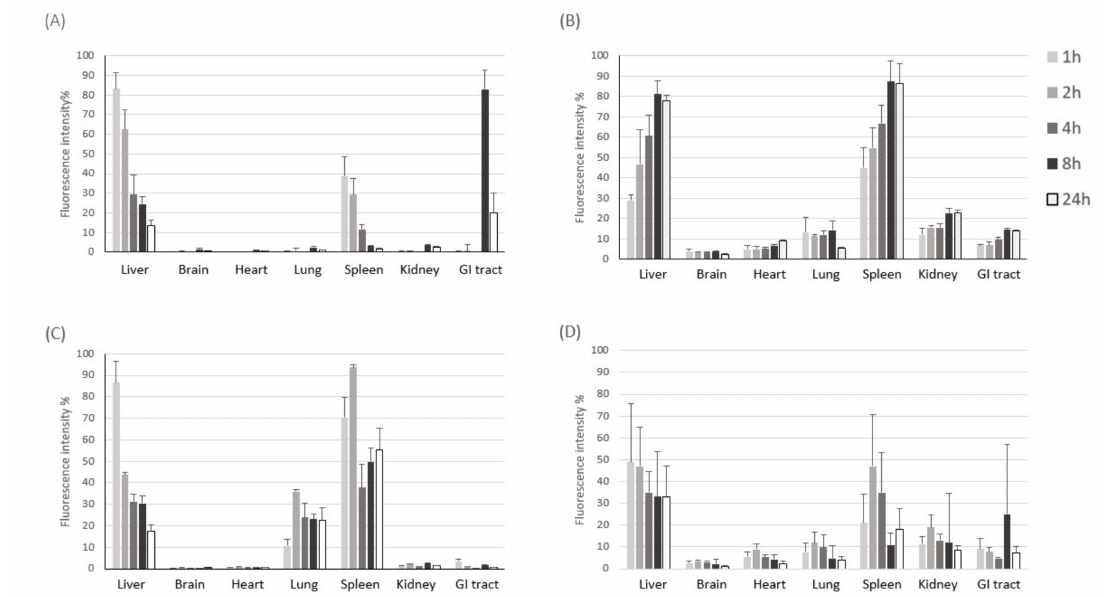
Figure 3. NIR fluorescence imaging of ex vivo organs after intravenous injection of HEK293T cell-derived exosomes and PEGylated liposomes. ( A , B ) Fluorescent signal intensity in each organ harvested at different time points after intravenous injection of DiR-labeled exosomes ( A ) and liposomes ( B ) into healthy mice. ( C , D ) Fluorescent signal intensity in each organ harvested at different time points after intravenous injection of DiR-labeled exosomes ( C ) and liposomes ( D ) into sepsis mice. The results represent mean ± SD ( n =